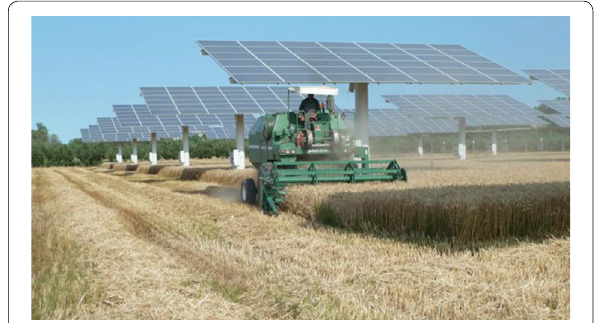
Fig. 4 Agro‑photovoltaic plant in Pagliare di Morro d’Oro (TE) (Source: Corditec)